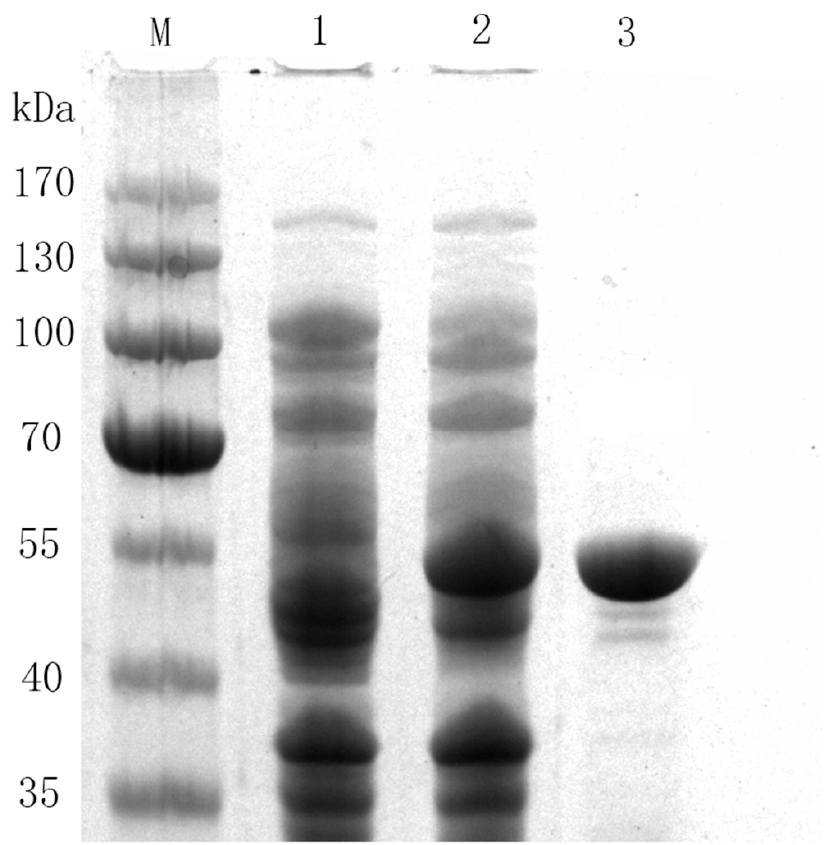
Figure 2. Polyacrylamide gel electrophoresis (SDS-PAGE) analysis of recombinant enzymes from E. coli . Lane 1: protein marker, lane 2: the crude extract of E. coli BL21 , lane 3: the crude extract of 78D1, and lane 4: purified 78D1.